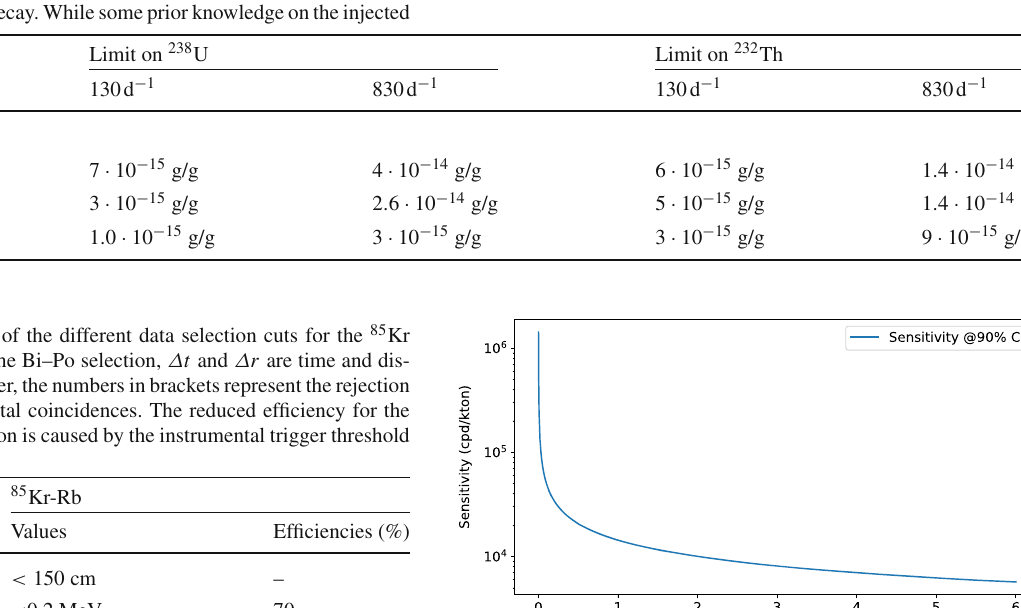
222 Rn contamination is required to reach U sensitivity close to the IBD level, 220 Rn decays sufficiently fast to show a distinct height gradient,